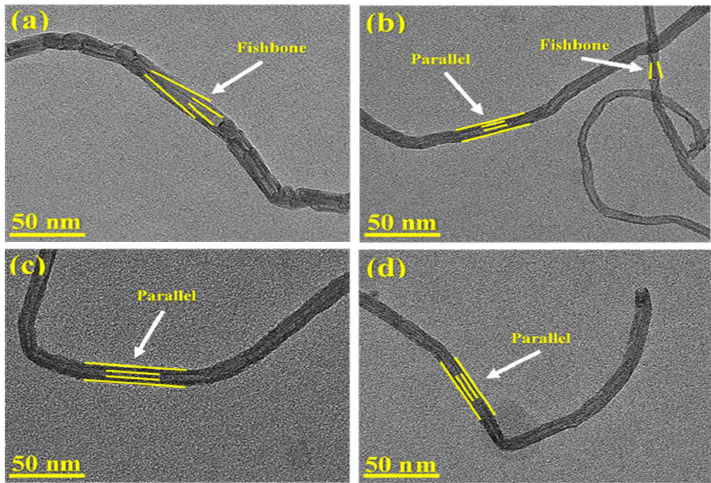
Figure 16. High magnification TEM images of the carbonous materials deposited over ( a ) Ni, ( b ) Ni- Co, ( c ) Ni-Fe, and ( d ) Ni-Cu catalysts. ( c ) Ni-Fe, and ( d ) Ni-Cu